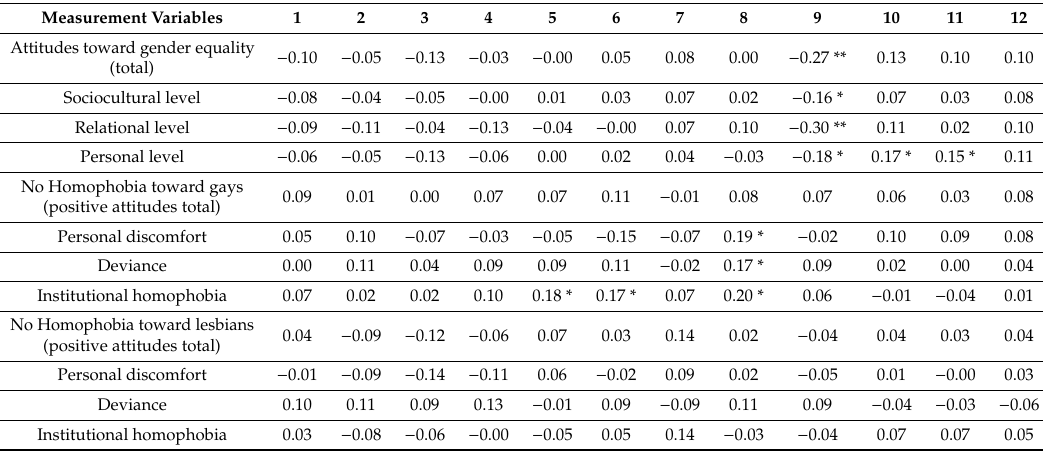
Table 3. Correlations between attitudes toward gender equality, homophobia toward gays and lesbians, self-esteem, emotional intelligence, empathy, levels of everyday stress, and resilience in university